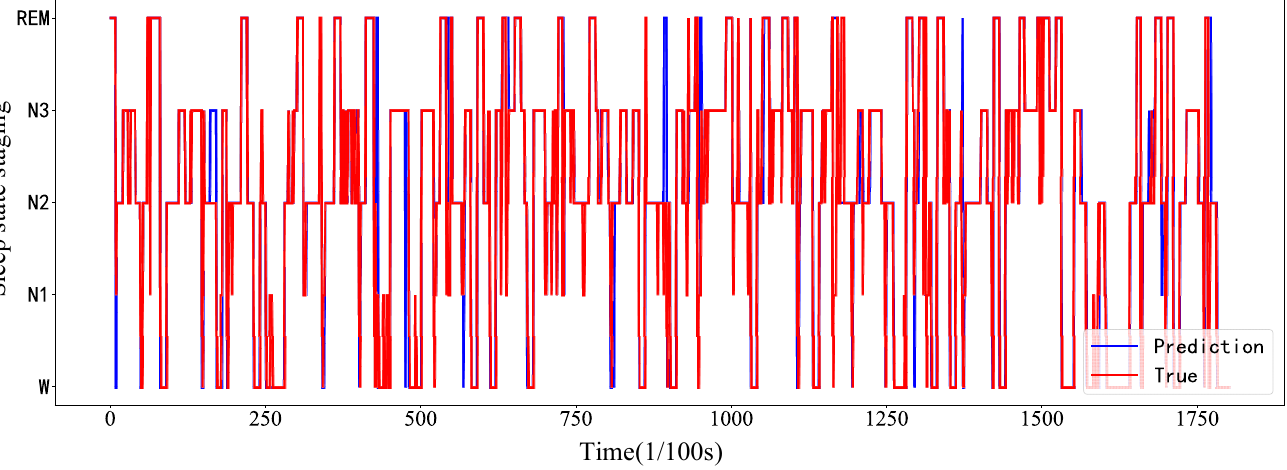
Figure 6. Comparison of the predicted and actual values.